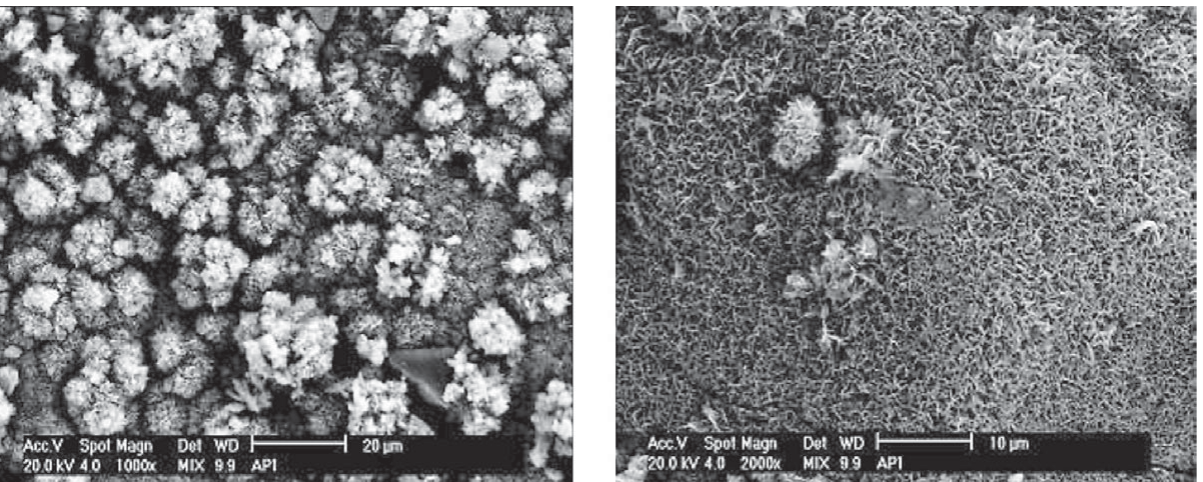
Figure 4. Micrographs of weathering steel specimen exposed at Alto da Serra , for one month, showing “cotton ball” structures, on the right, and nest formations, on the left, interconnecting the cotton